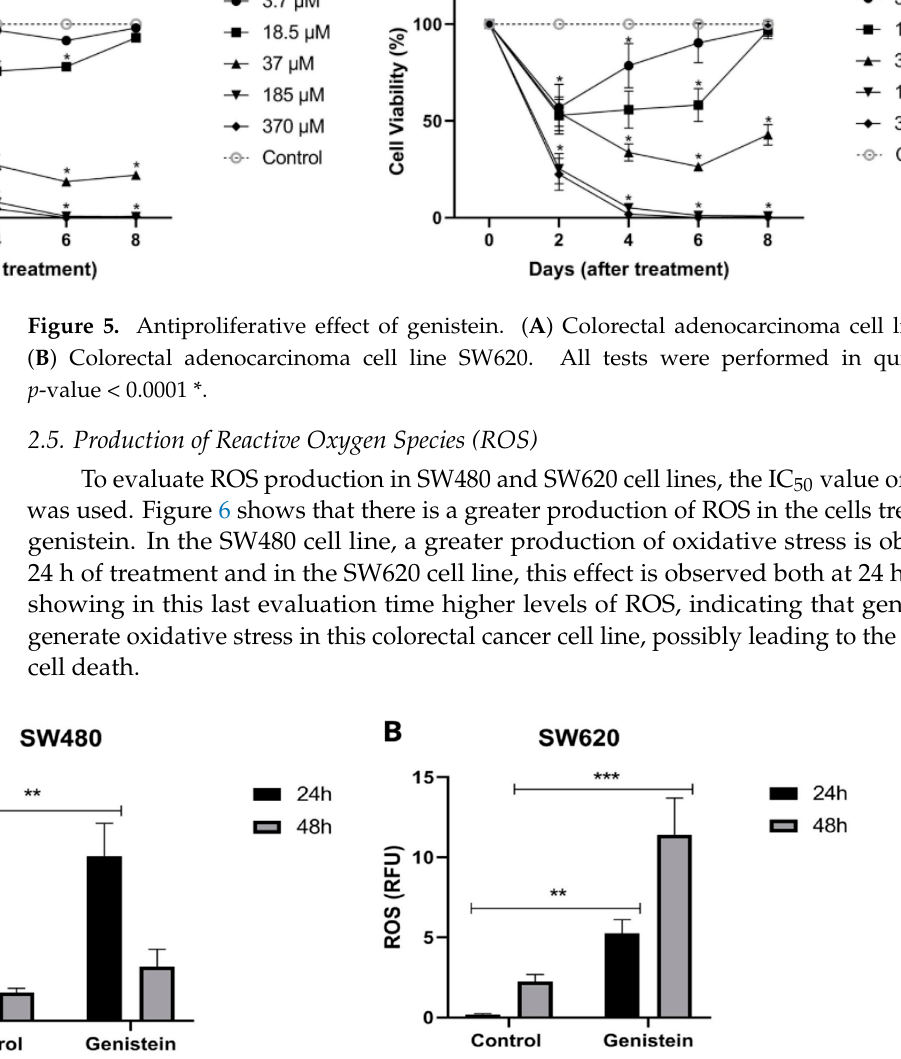
Figure 6. Effect of genistein on the production of reactive oxygen species (ROS) after treatment with genistein in two periods of time (24 h and 48 h). ( A ) SW480 cell line and ( B ) SW620 cell line. All tests were performed in triplicate. RFU: Relative Fluorescence Units. p -value < 0.01 **; and p < 0.001 ***.